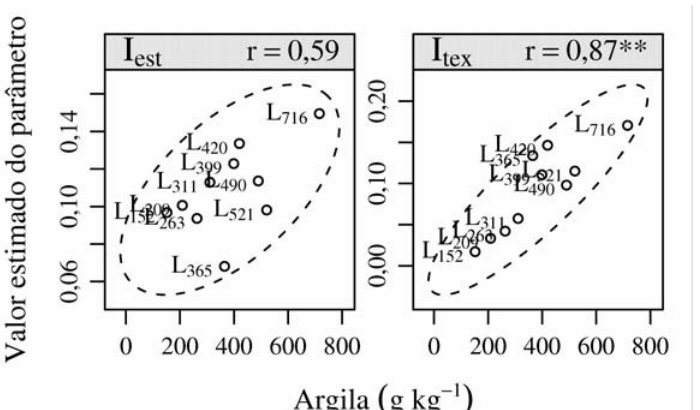
Figura 4. Correlações de Pearson entre a primeira inclinação (I retenção de água com o conteúdo de argila dos Latossolos